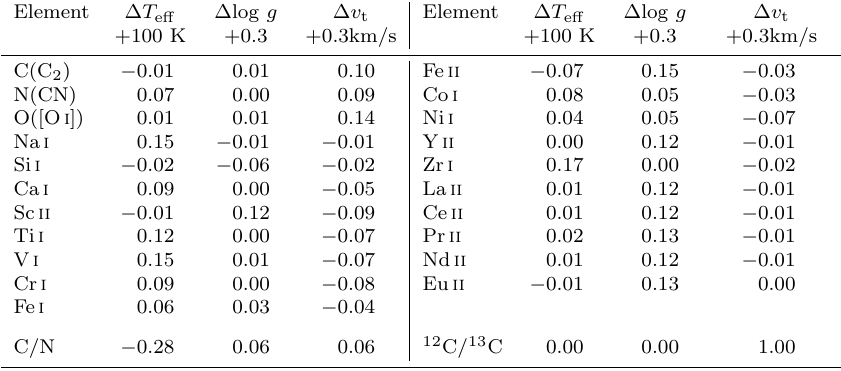
Table 2. The sensitivity of abundances to the changes in the atmospheric parameters. The table entries show the effects on the logarithmic abundance relative to hydrogen, ∆ [A/H].